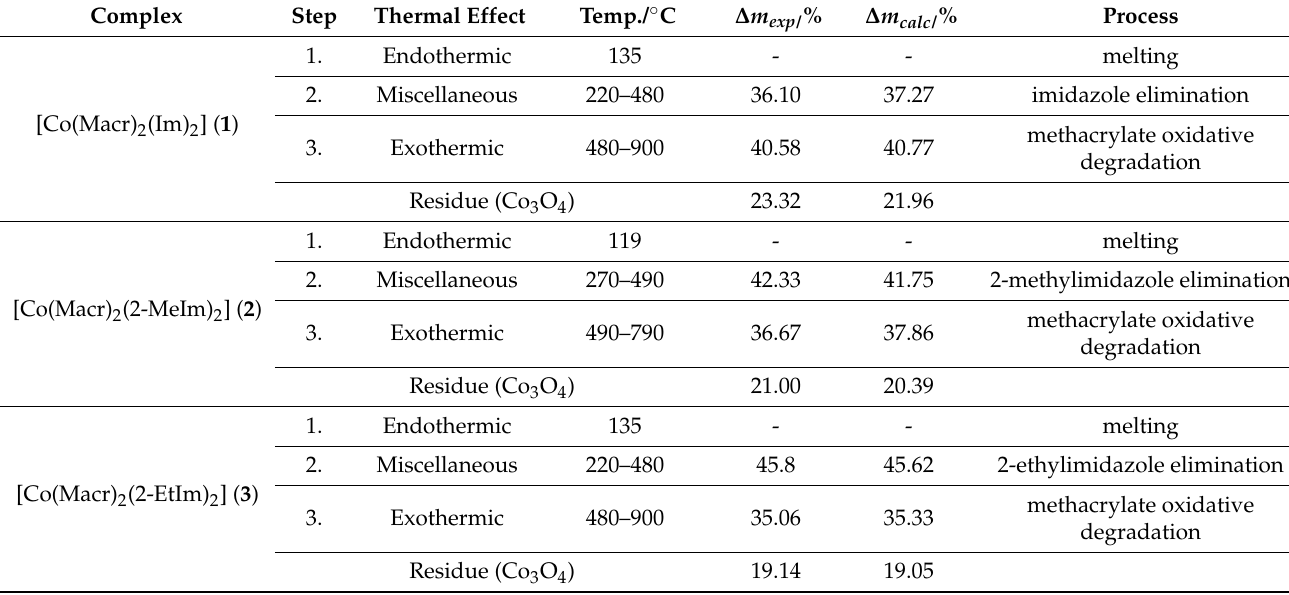
Table 5. Thermal decomposition data (in air flow) for complexes ( 1 )–( 3 ).